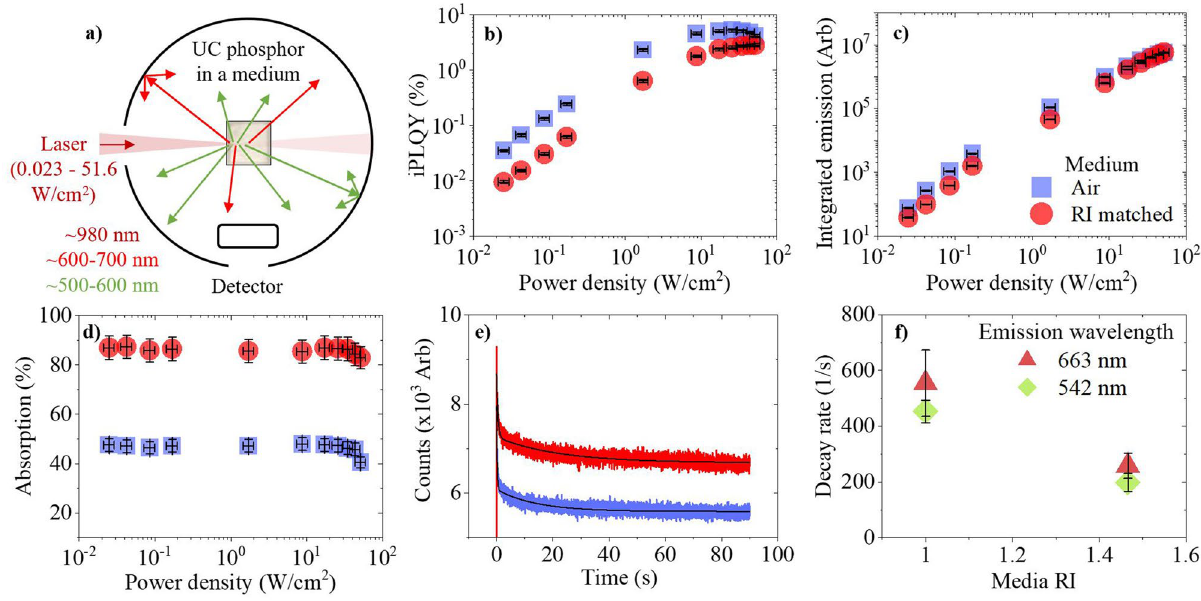
Figure 1. β-NaYF 4 :(18%)Yb 3+ ,(2%)Er 3+ microscale phosphor is placed in air (blue square) or a RI-matched medium (red circle) and excited with a 980 nm laser diode inside an integrating sphere, as depicted in ( a ). The following was obtained against excitation PD: ( b ) iPLQY (500–700 nm), ( c ) integrated emission (500–700 nm), and ( d ) absorption. Excitation induced thermal effects are then investigated to obtain ( e ) the 542 nm emission decay versus excitation time, and ( f ) the 542 nm (rotated green square) and 663 nm (dark red triangle) emission decay rate versus media